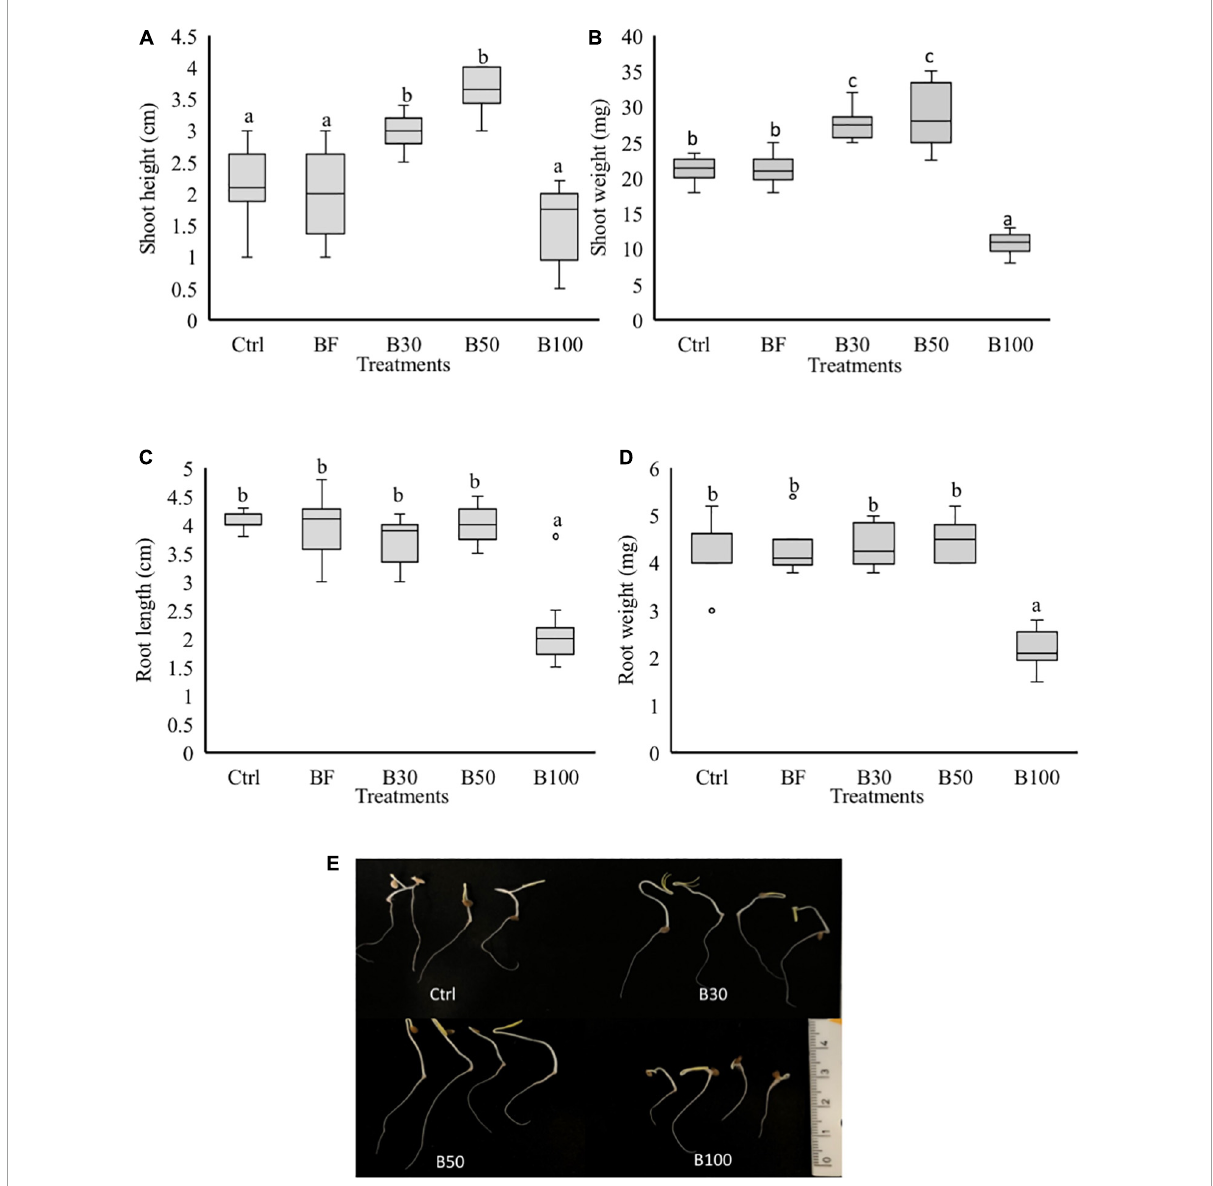
FIGURE4 Phenotypic effect of P. polymyxa LMG27872 on tomato seedlings. Treatment of 3-day-old seedlings with 1 mL of bacterial inoculum at different bacterial suspension doses of 30, 50, and 100% was performed, while control plants were mock- and buffer-treated. The (A) SH, (B) SW, (C) RL, and (D) RW measured at 5 days after application. (E) Shoot and root growth of 5-day-old seedlings treated with 30, 50, and 100% BS. Data analyzed by one-way ANOVA, followed by Tukey’s post-hoc test, and data are shown by box plots with median, upper, and lower quartiles. Different letters indicate statistically different means at 95%